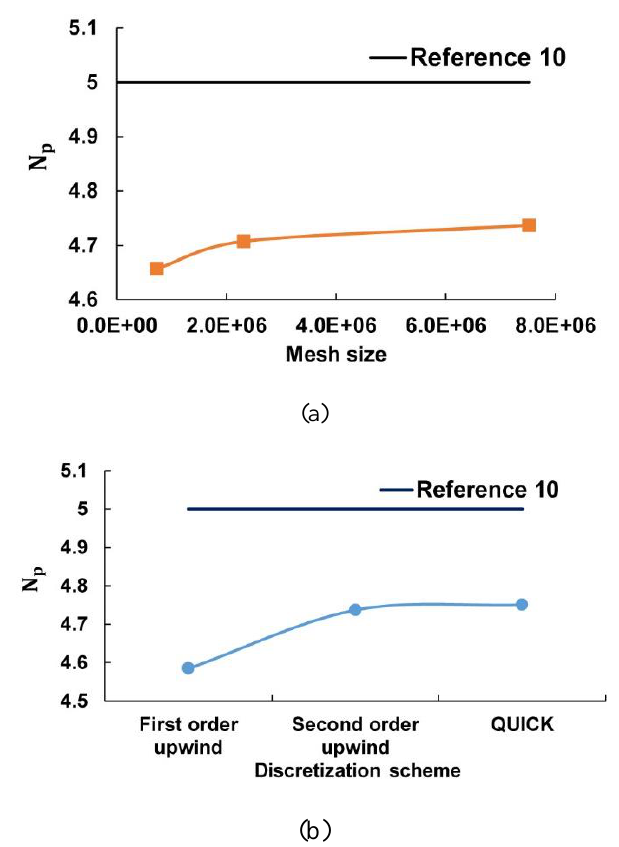
Figure 3. Effects of (a) grid resolution and (b) discretization schemes on 𝑁